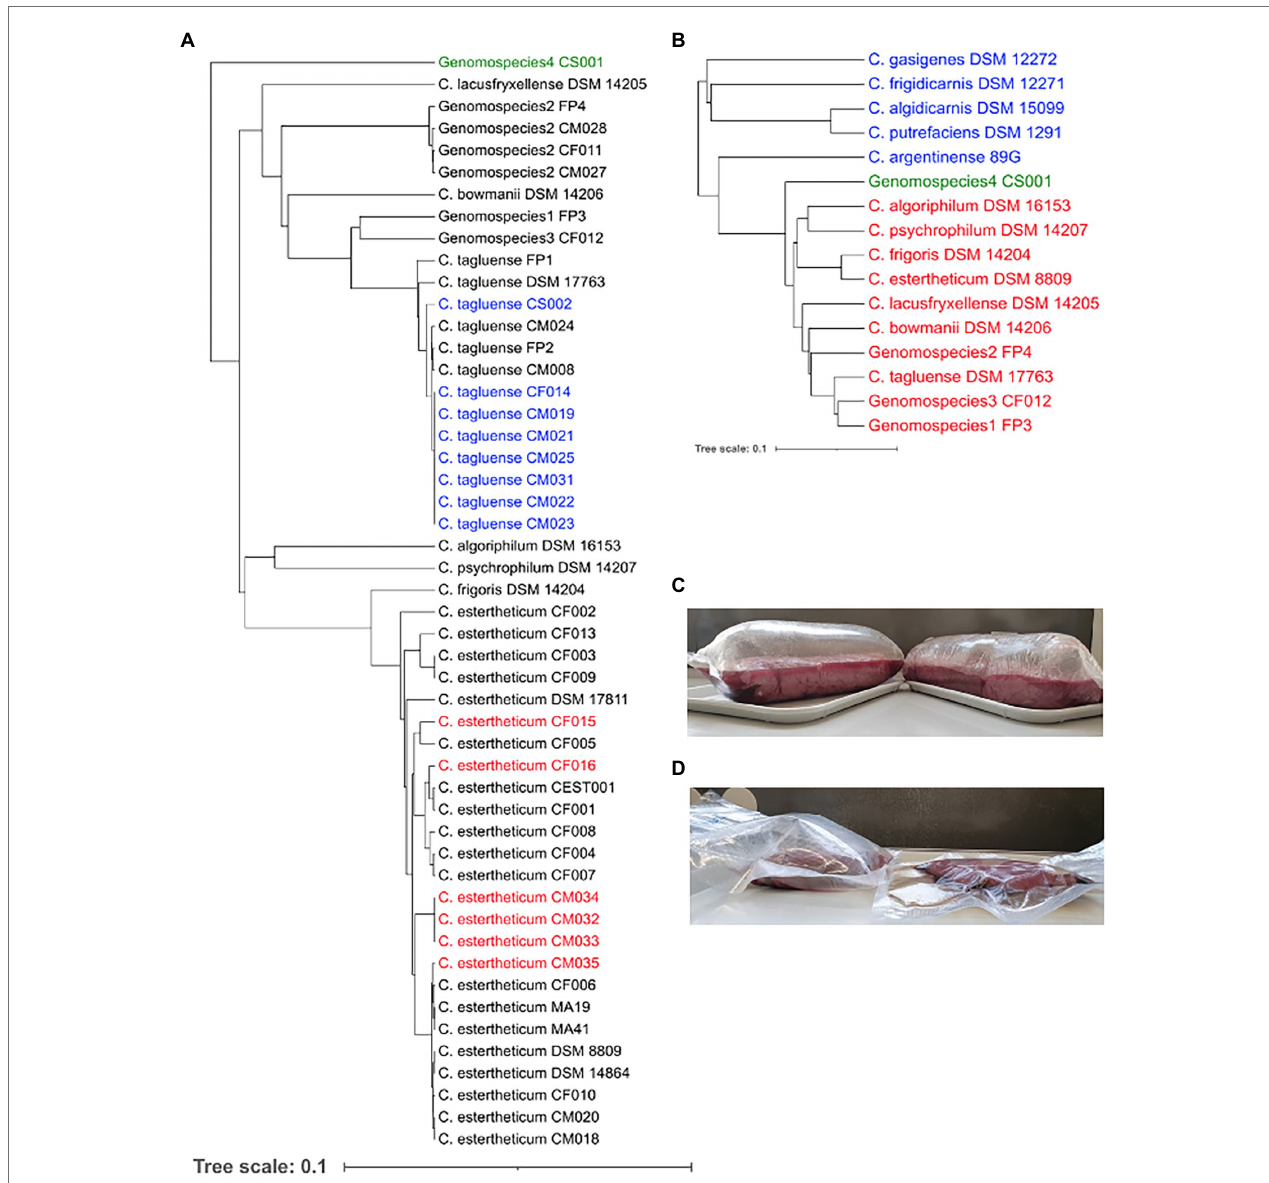
FIGURE 1 | Identification of new Clostridium estertheticum complex (CEC) isolates. (A) rpoB gene-based phylogeny of CEC strains. Newly isolated C. estertheticum , C. tagluense, and genomospecies4 strains are highlighted in red, blue, and green text, respectively. (B) Genomospecies4 CS001 (green) was confirmed as a novel member of CEC using the rpoB gene-based phylogenetic analysis of type/representative strains of CEC (red) and other related Clostridia spp. (blue). (C) Blown pack spoilage cases of horse meat that were likely caused by C. estertheticum CM033 and CM034. (D) Blowing ability of C. estertheticum CM034 (left) in beef against uninoculated beef